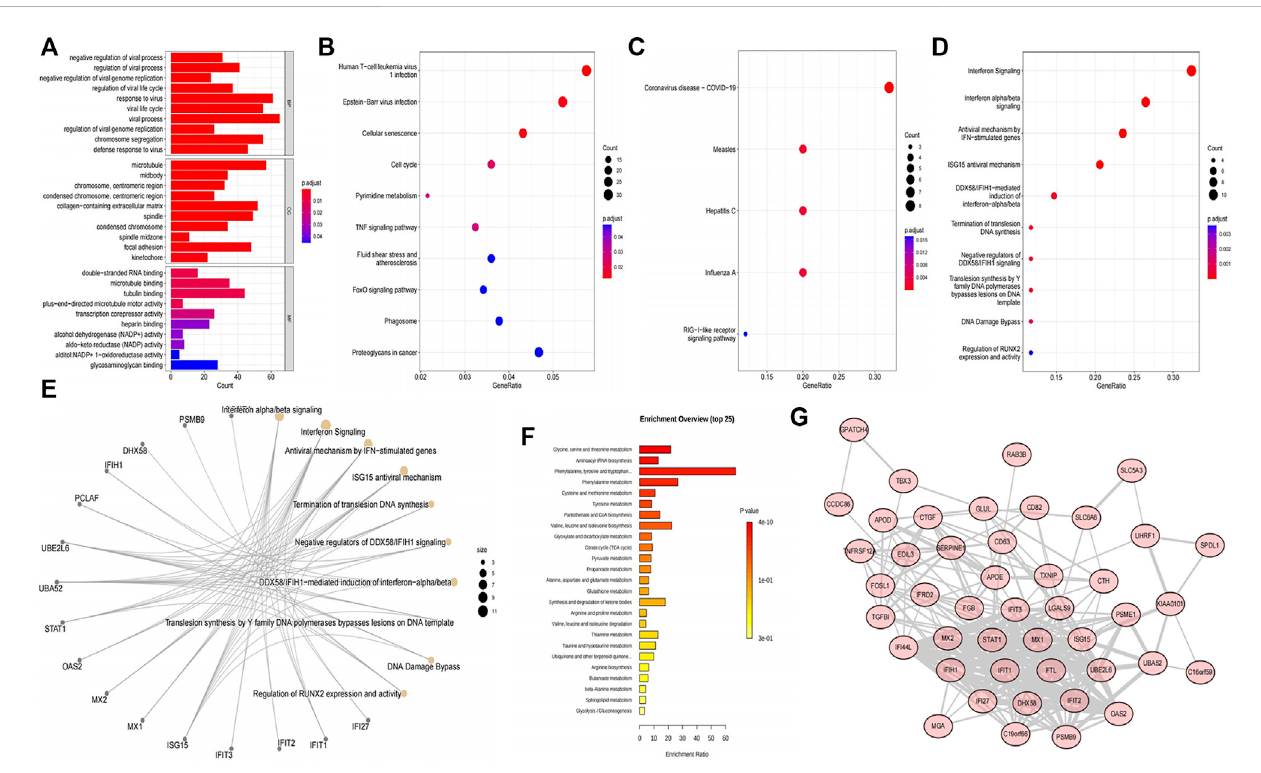
FIGURE 2 Functional enrichmentanalysesandconstructionoftheprotein-protein interaction(PPI)network. (A) Barchart ofthetop10mostenriched GOtermsof the DEGs. (B) Bubble chart of the 10 most activated KEGG pathways of the DEGs. (C) Bubble chart of the fi ve most activated KEGG pathways of the DEPs. (D) Bubblechartofthe10mostenrichedREACTOMEannotationsoftheDEPs. (E) Interactionnetworkofthetop10REACTOMEpathwaysandDEPs.Yellownodes indicate the REACTOME pathways, gray nodes indicate the DEPs, and the lines indicate the interaction of proteins and the pathways. (F) Top 25 most activated pathways of the DEMs in MetaboAnalyst website. (G) PPI network of DEPs. The nodes represent the proteins, the lines represent the interaction relationship, and the line thickness was positively correlated with the combined